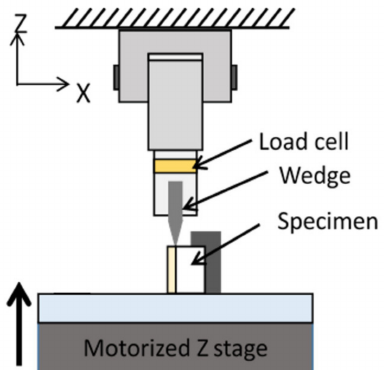
Figure 3. Adapted test setup for the interface toughness test.